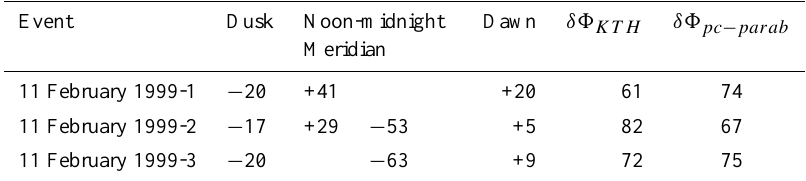
Table 4. Local potential extrema (kV). Event